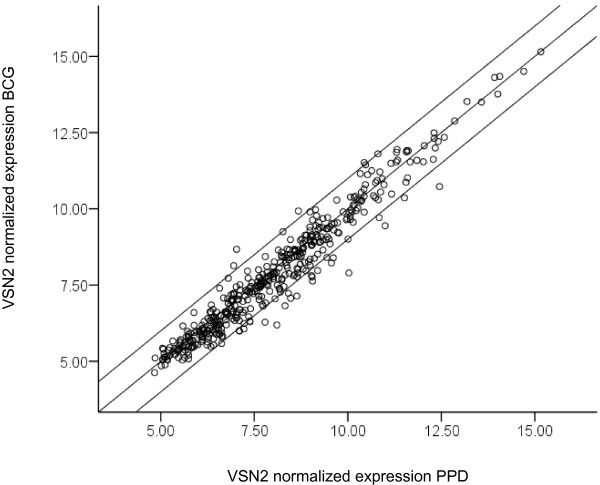
Comparison of gene expression induced in response to stimulation with PPD and with BCG. Data was normalized using a variance stabilization method (VSN2) and genes significantly induced by stimulation with PPD and BCG, as compared with the unstimulated control, were combined into a single gene list: the scatter of these genes in response to either stimulation is shown. Spearman's rank test was used to assess the correlation (r = 0.965, p < 0.000001). The lines indicate a greater than 2 fold difference in expression.